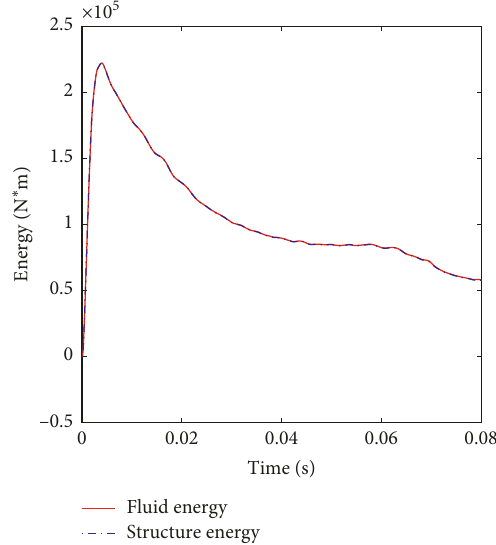
Figure 18: Energy history on fluid and structure